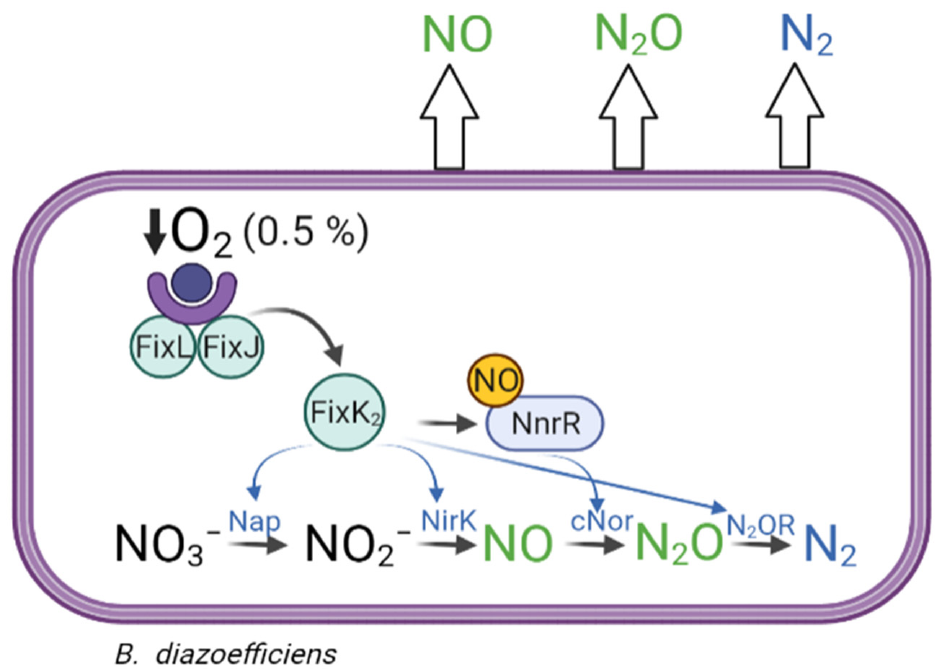
Figure 1. Schematic representation of the denitrification process and its regulation in Bradyrhizobium diazoefficiens . B. diazoefficiens can reduce nitrate (NO 3 − ) to nitrite (NO 2 − ), nitric oxide (NO), nitrous oxide (N 2 O), and dinitrogen (N 2 ) by the periplasmic nitrate reductase (Nap), copper-containing nitrite reductase (NirK), nitric oxide reductase type c (cNor), and nitrous oxide reductase (N 2 OR) enzymes, respectively. In B. diazoefficiens, expression of denitrification enzymes is tightly regulated by the FixLJ, FixK 2 , and NnrR regulatory proteins (see Introduction for further details). However, despite the coordinated activation of each reductase, environmental unfriendly gases such as NO and N 2 O can leak from denitrification and be released to the atmosphere.